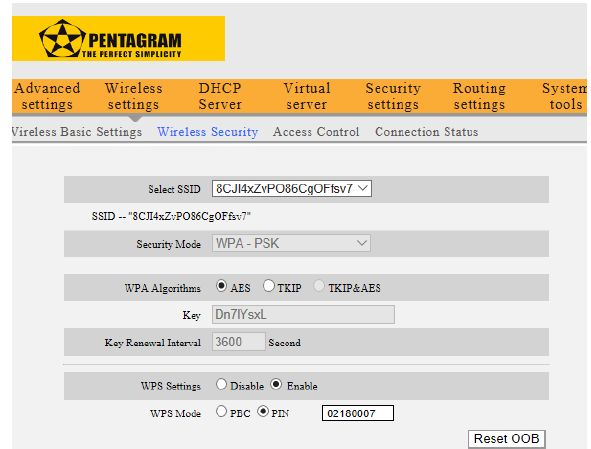
Fig. 5. Screenshot of the security settings page of the test network used to test the WPS